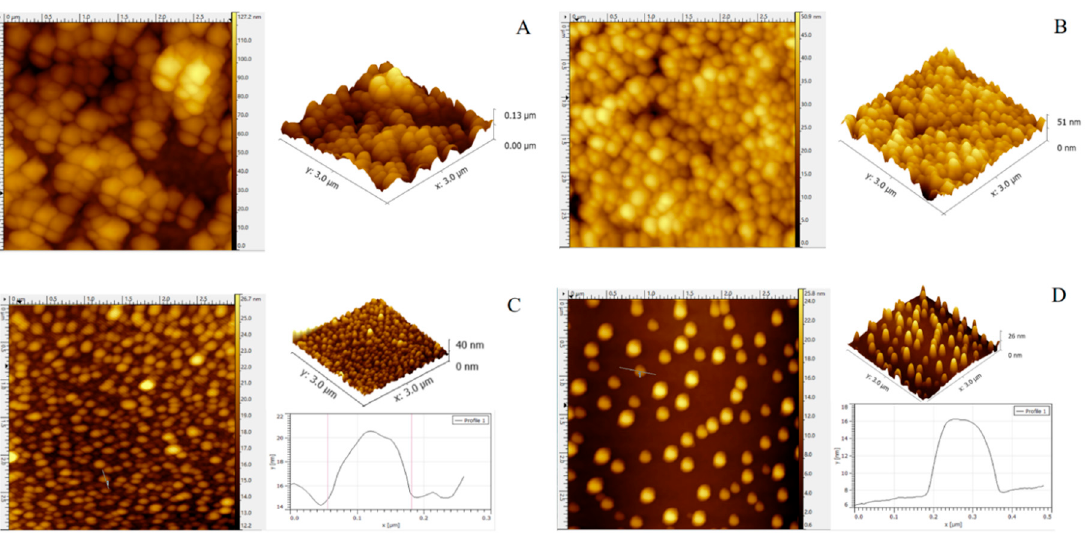
Figure 6. 2D / 3D Atomic force microscopy (AFM) images of BpTA-1 and BpTA-2. ( A ) Enzyme BpTA-1 diluted 20-fold; ( B ) Enzyme BpTA-2 diluted 20-fold; ( C ) Enzyme BpTA-1 diluted 200-fold and the size of its single particles; ( D ) Enzyme BpTA-2 diluted 200-fold and the size of its single particles.